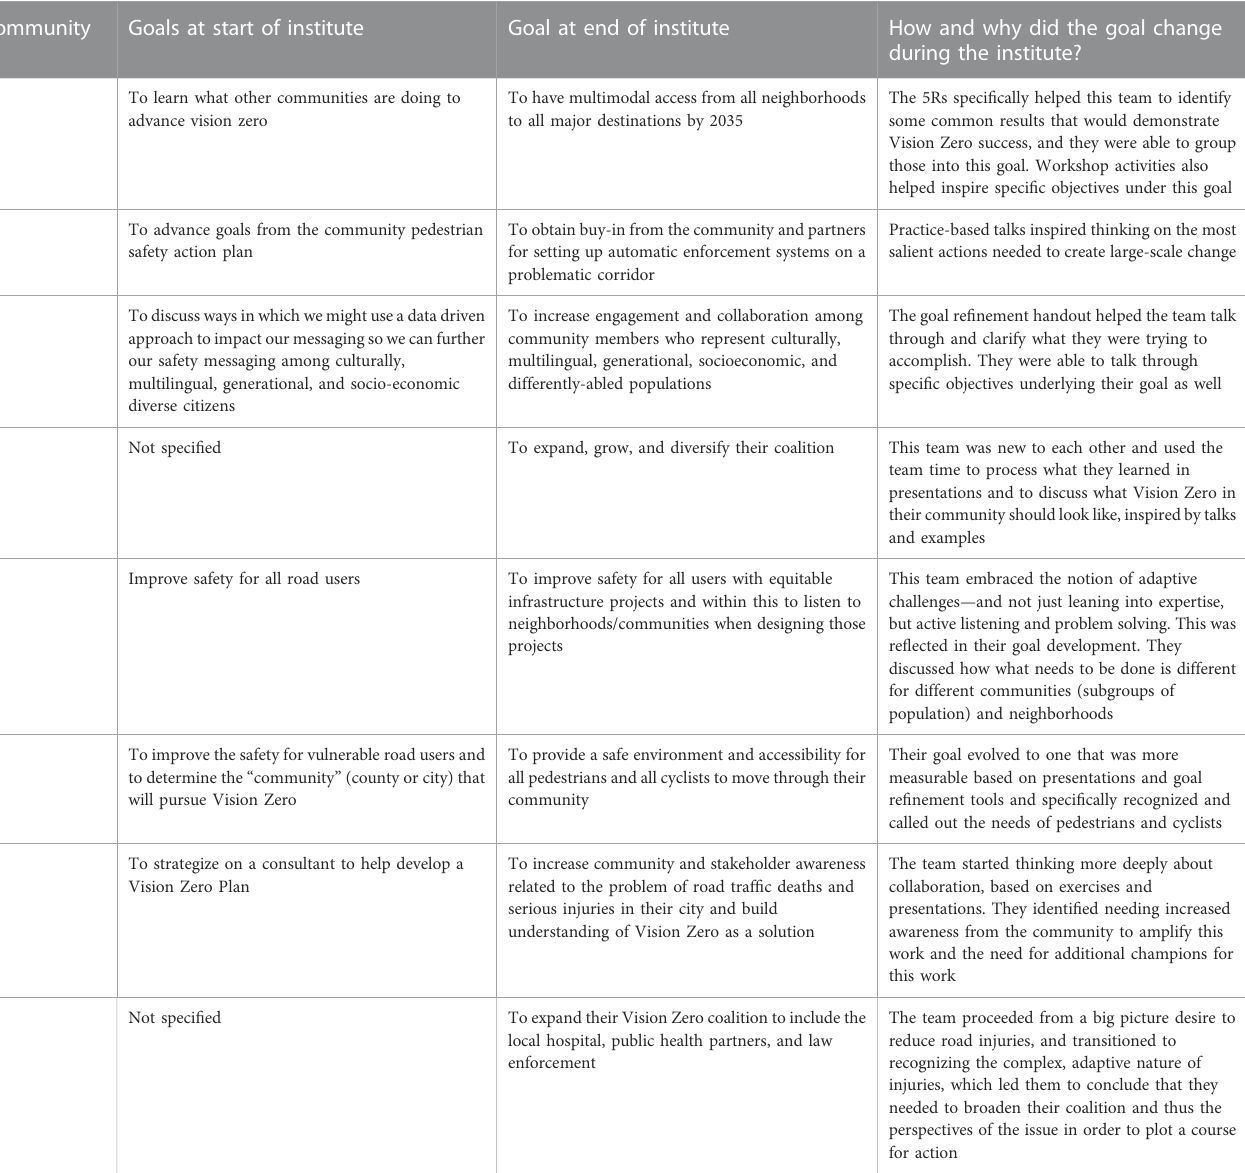
TABLE 3 Goal evolution of teams participating in the Vision Zero